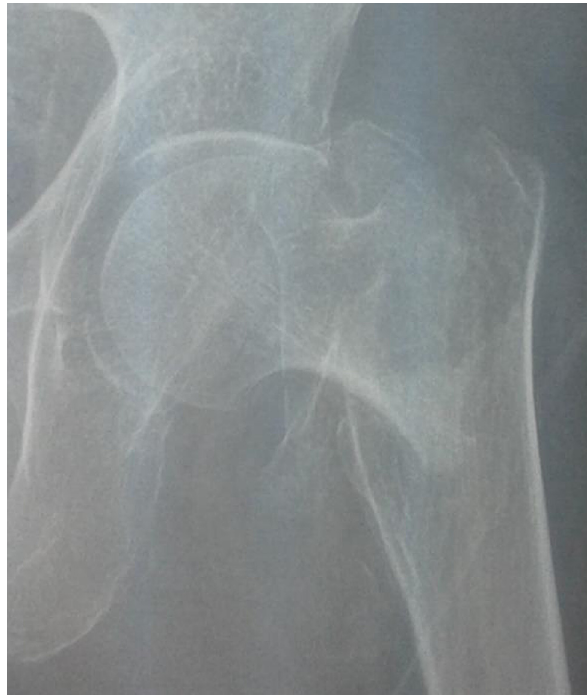
Figure 3. Pre operation X-ray.